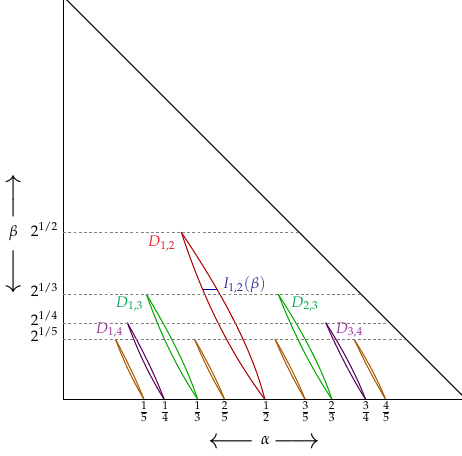
Figure 1. Plot of the parameter space ∆ , together with boundary of the regions D 1,2 , D 1,3 , D 2,3 , D 1,4 , D 3,4 , D 1,5 , D 2,5 , D 3,5 , D 4,5 , D 1,6 and D 5,6 . Further, in blue, a sketch of the interval I 1,2 ( β ) , where β is the square root of the golden mean, is